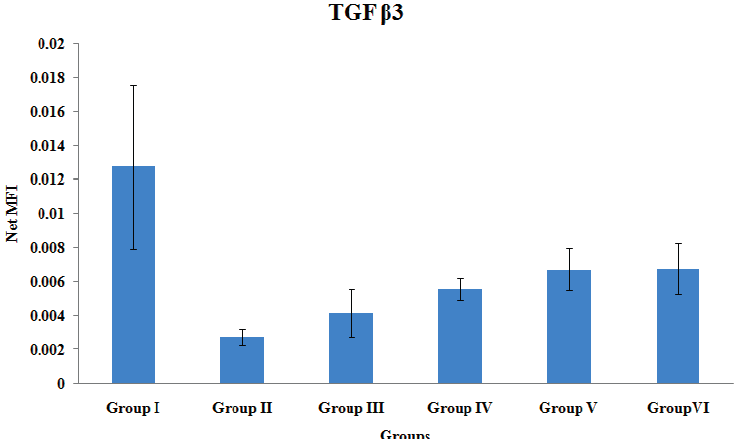
Figure 7. TGF β 3 Gene Expression. Samples were normalized to GAPDH MFI (Median Fluorescence Intensity). Values were expressed as mean ± SEM. Group I: sham-operated